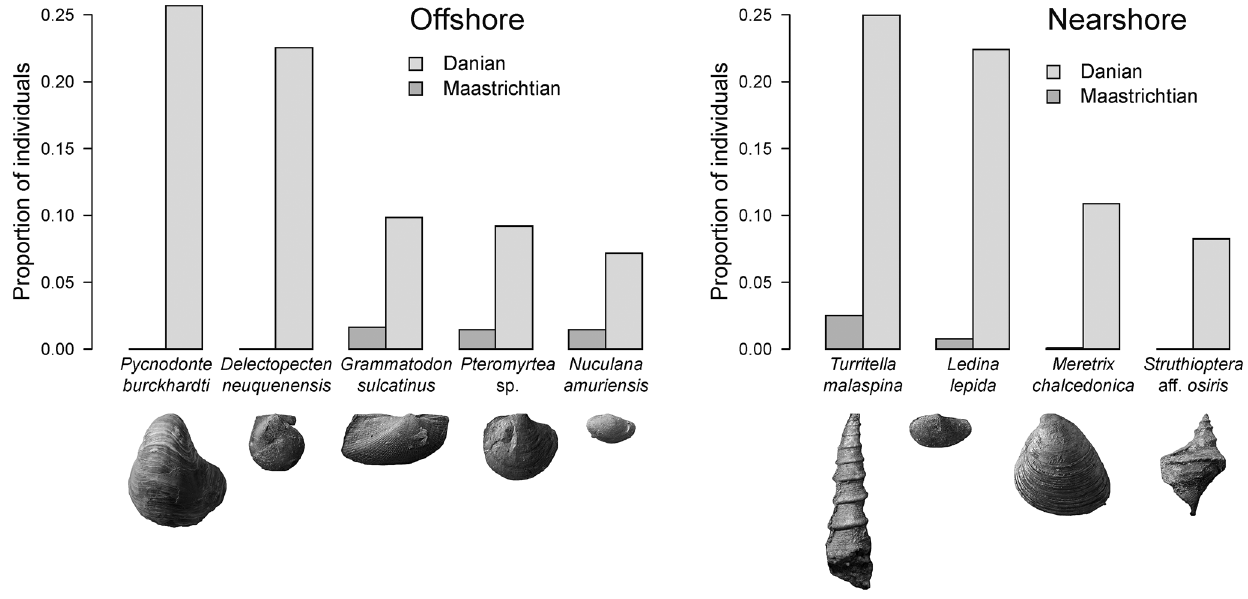
Figure 5. Proportional abundance of most common Danian molluscs contrasted with their abundances in the Maastrichtian. The displayed Danian species are those in the upper 90 th percentile of the pooled samples of that time. Their Maastrichtian proportions are plotted alongside. Most of the dominant Danian species are survivors that were rare during the Maastrichtian. The two most abundant Danian offshore species are Patagonian endemics that newly originated in the early Danian.